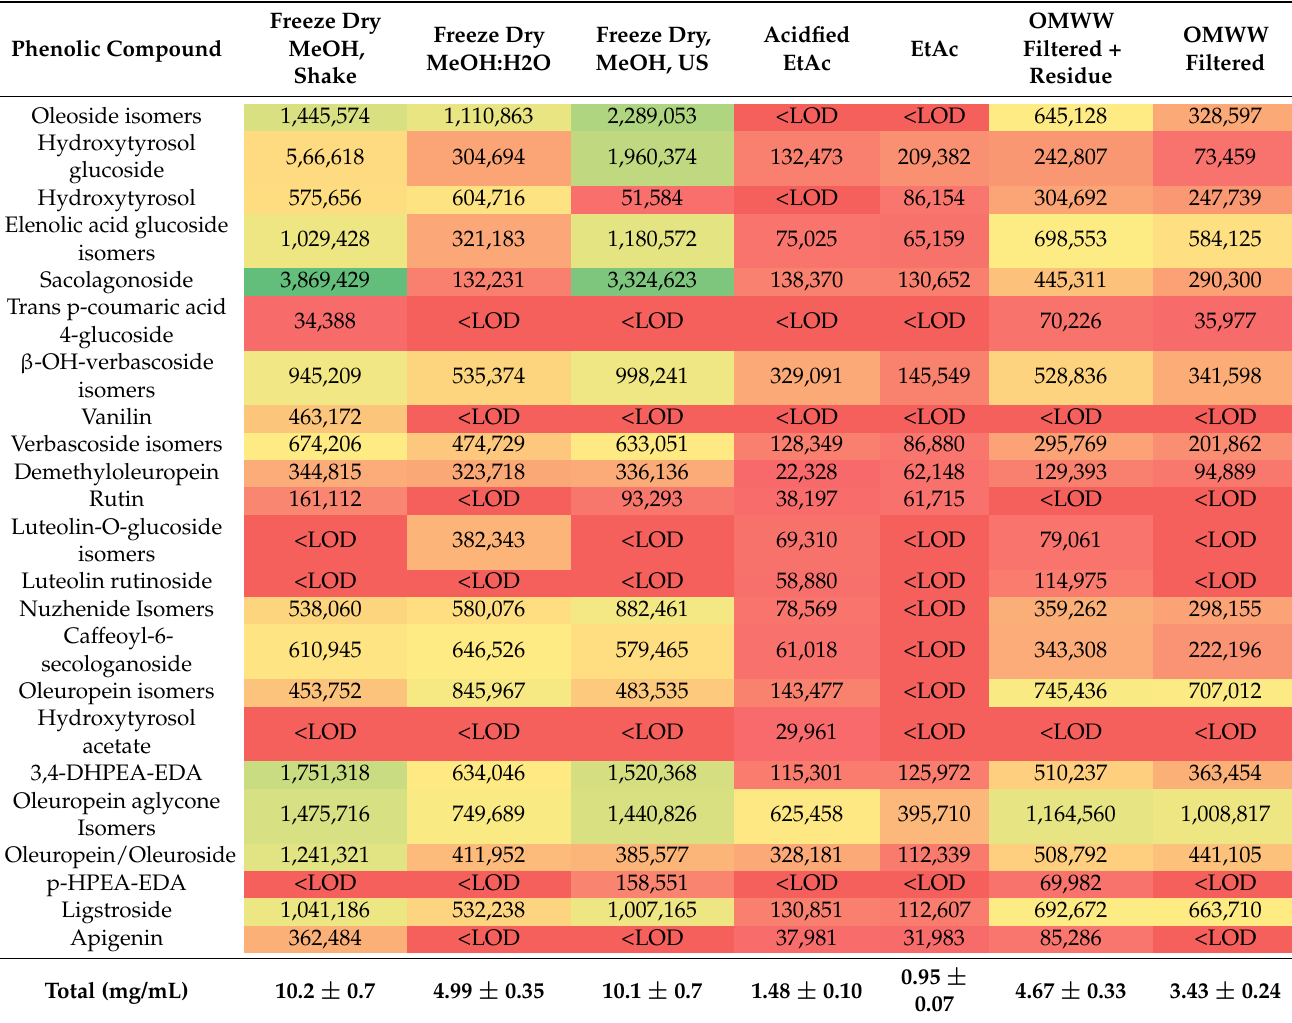
Table 1. Comparison between different OMWW treatment techniques to determine their polyphenol content. Individual phenolic compounds are semi-quantified (counts on the MS detector), total phenolic concentrations are in